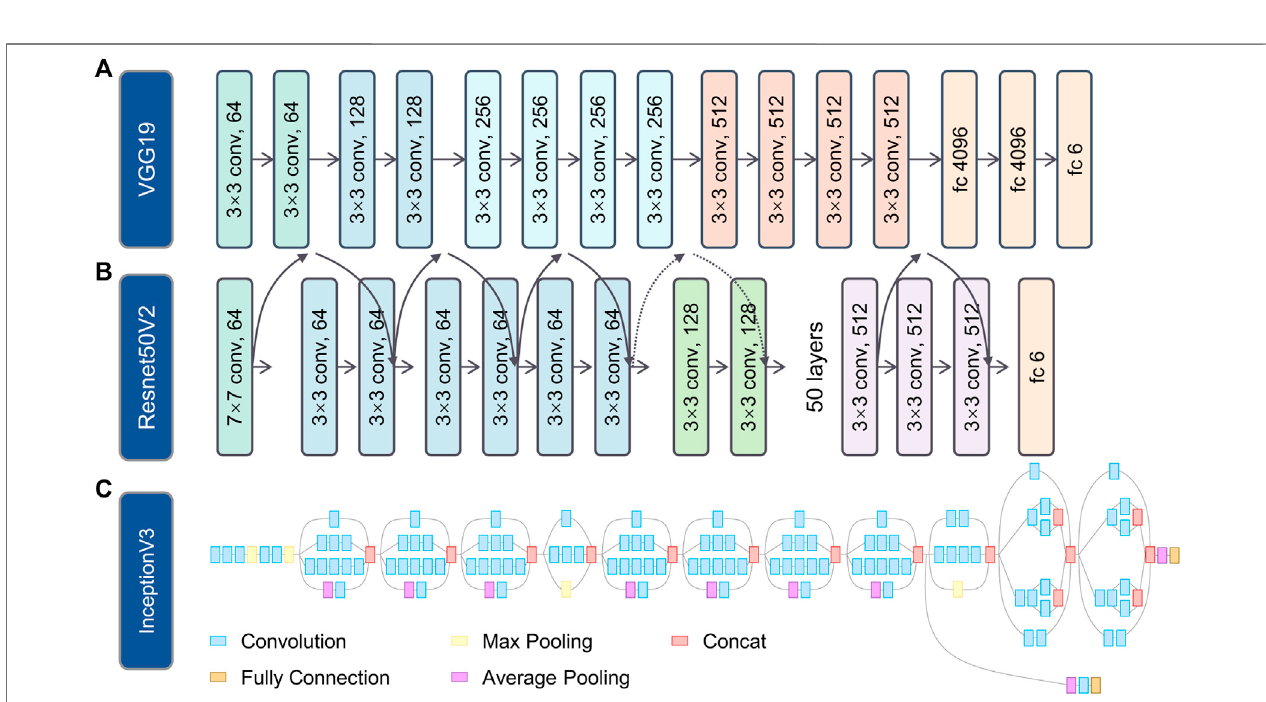
FIGURE6| Architecturesoftypicaldeepneuralnetworks: (A) VGG19; (B) ResNet50V2.ResNetV2comprisesdifferentdepthnetworkmodels,whereResNet50V2 has 50 layers; and (C) InceptionV3.